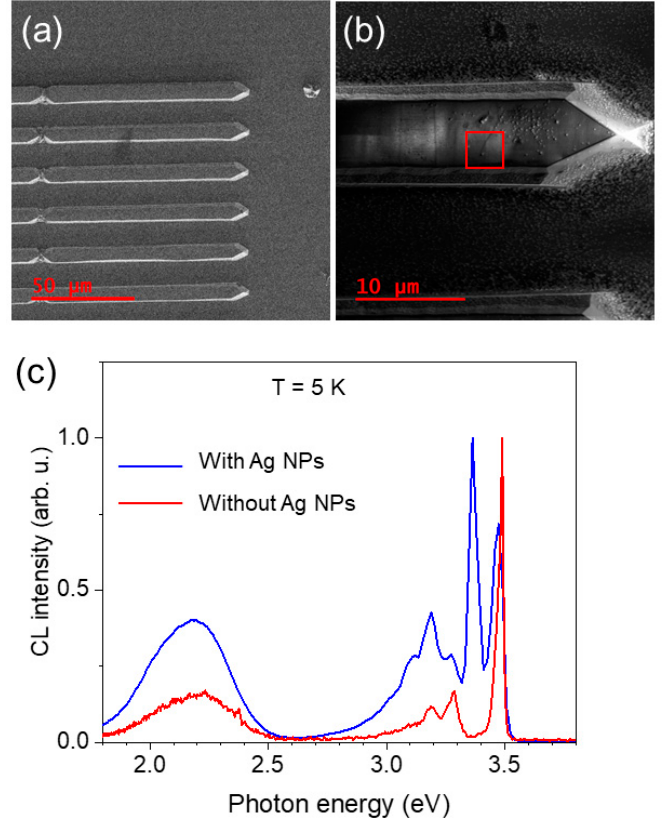
Figure 1. ( a ) Overview of SEM image of the planar GaN NWs without Ag NPs. ( b ) SEM image of one planar GaN NW with Ag NPs on the surface. The square indicates where the CL spectrum was measured. ( c ) Normalized CL spectra taken at 5 K for GaN NW without Ag NPs (red line) and with Ag NPs (blue line).